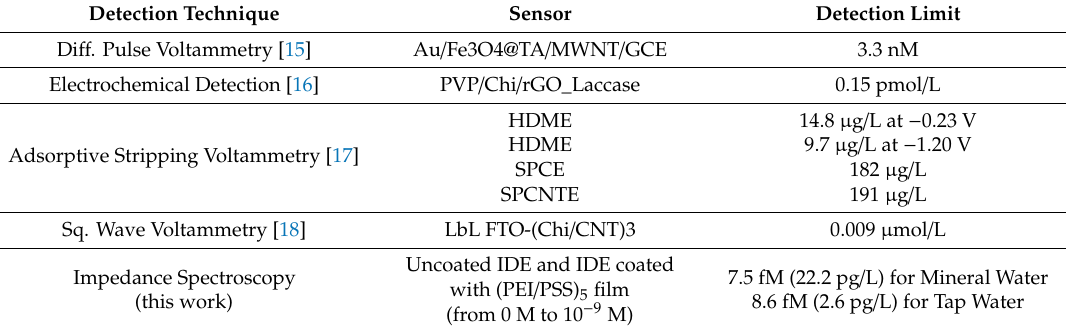
Table 1. Comparison of the responses of sensors in the literature with those of this